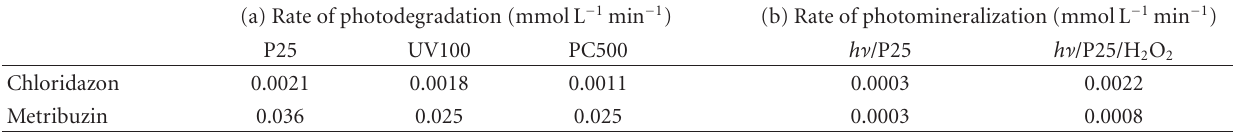
Table 1: (a) Comparison of degradation rate of CHL and MET in the presence of di ff erent types of TiO 2 samples. Experimental conditions: CHL (0.18 mM), MET (0.30 mM), V = 125mL, photocatalysts: Degussa P25 (1gL − 1 ), Sachtleben Hombikat UV100 (1gL − 1 ), PC500 (1g − 1 ), irradiation time: 60 min (CHL), 28min (MET). (b) Comparison of mineralization rate of CHL and MET in the presence of TiO 2 and TiO 2 /H 2 O 2 . Experimental conditions: CHL (0.55 mM), MET (0.11mM), V = 125 mL, photocatalysts: Degussa P25 (1gL − 1 ), irradiation time: 60 min (CHL), 28min